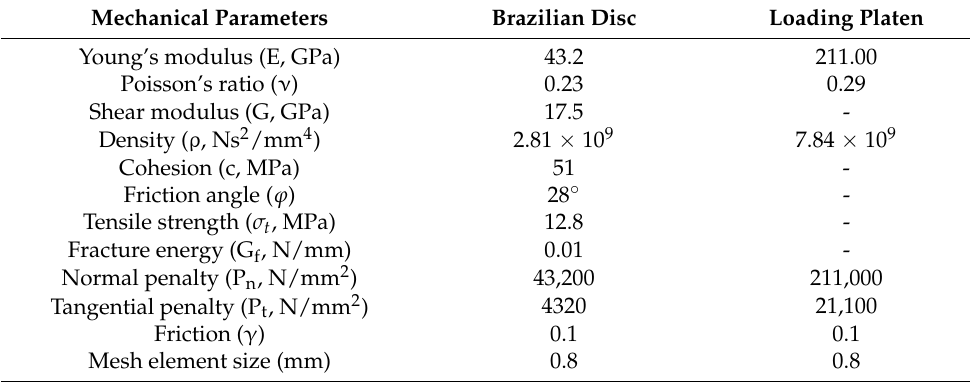
Table 1. Material property of